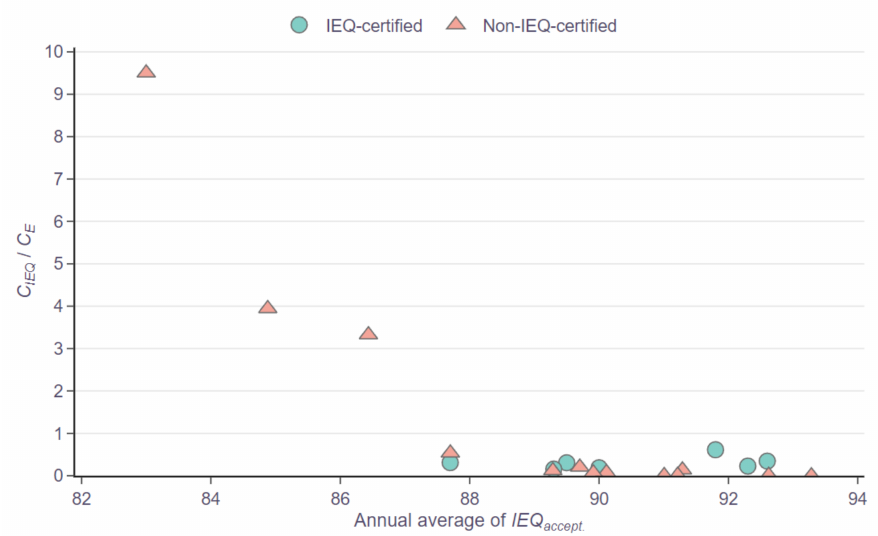
Figure 6. Cost ratios of the investigated